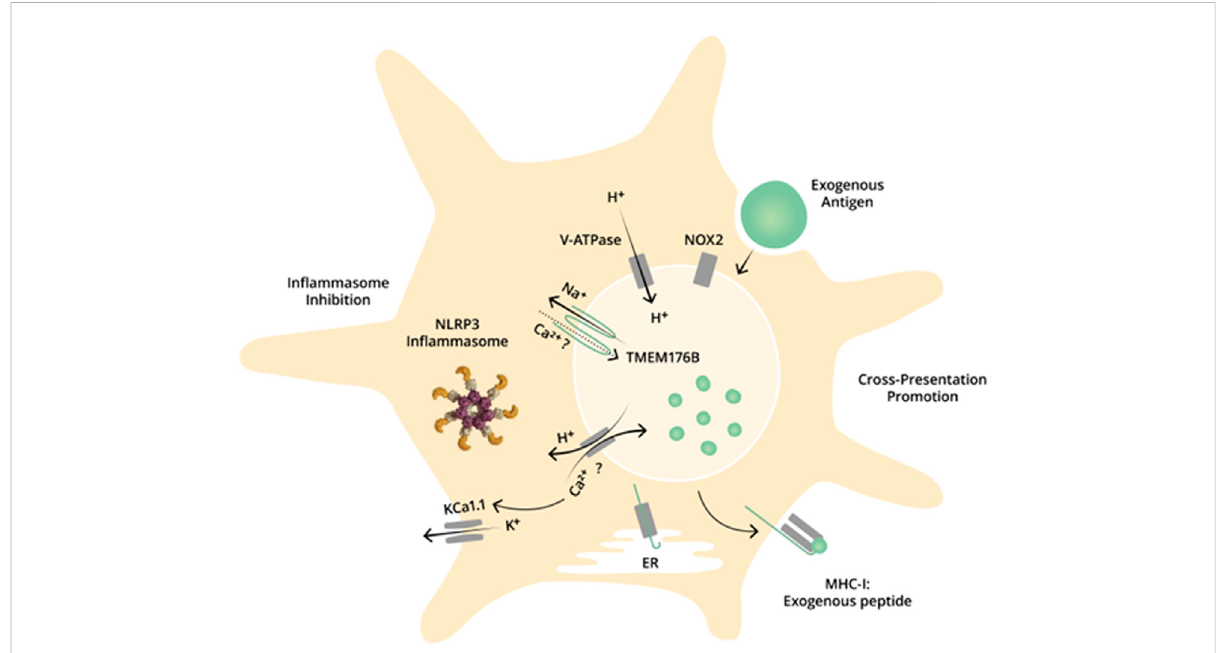
FIGURE 1 Dual role of TMEM176B in DCs: promotion of antigen cross-presentation and inhibition of in fl ammasome activation. TMEM176B at the endophagosmal membrane in DCs. TMEM176B exports Na + from the endophagosomal lumen to the cytosol. This conductance alleviates the electrochemicalgradientto V-ATPase,promotingthepumpingofH + intothelumen.AneutralpHintheendophagosomallumen inDCsiscriticalto processantigensthroughthecross-presentationpathway.Accordingly,deletionof Tmem176b isassociatedwithdiminishedV-ATPaseactivity, alkalinized phagosomal pH and impaired antigen cross-presentation. Moreover, TMEM176B inhibits NLRP3 in fl ammasome activation through ionic mechanisms. Tmem176b deletion is associated with KCa1.1-dependent in fl ammasome activation. TMEM176B controls cytosolic Ca 2+ levels although the mechanisms of this effect remain unknown. Ca 2+ might be internalized via TMEM176B into the phagosomal lumen and/or TMEM176B activity may promote H + /Ca 2+ interchange, leading to decreased cytosolic Ca 2+